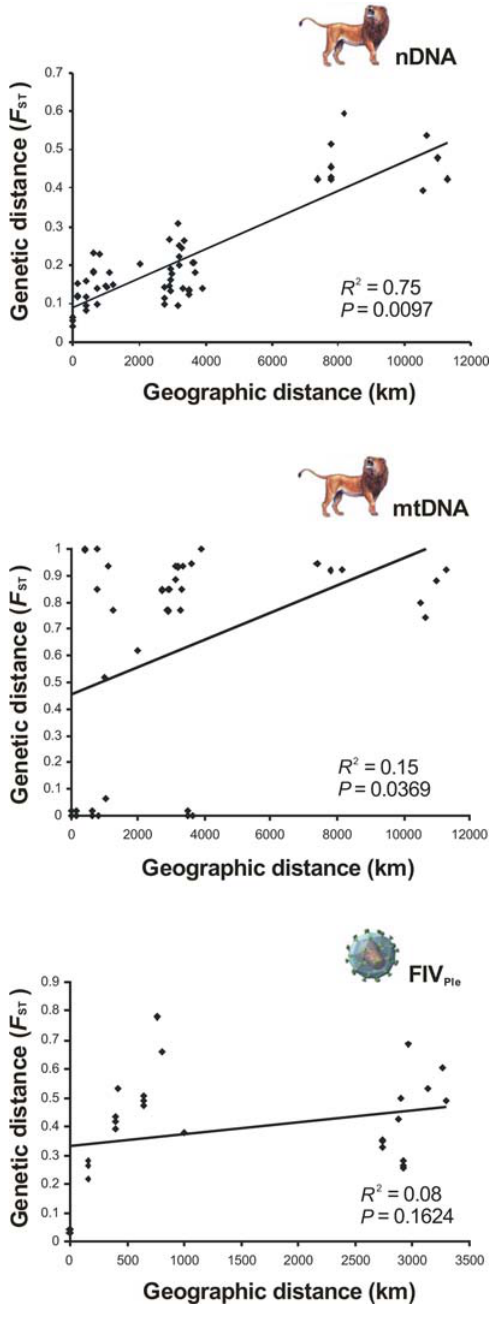
Figure 3. Genetic differentiation of host and viral genetic markers with geographic distance. Regression of lion pairwise F ST (nDNA and mtDNA) and FIV Ple ( pol -RT) on geographic distance.